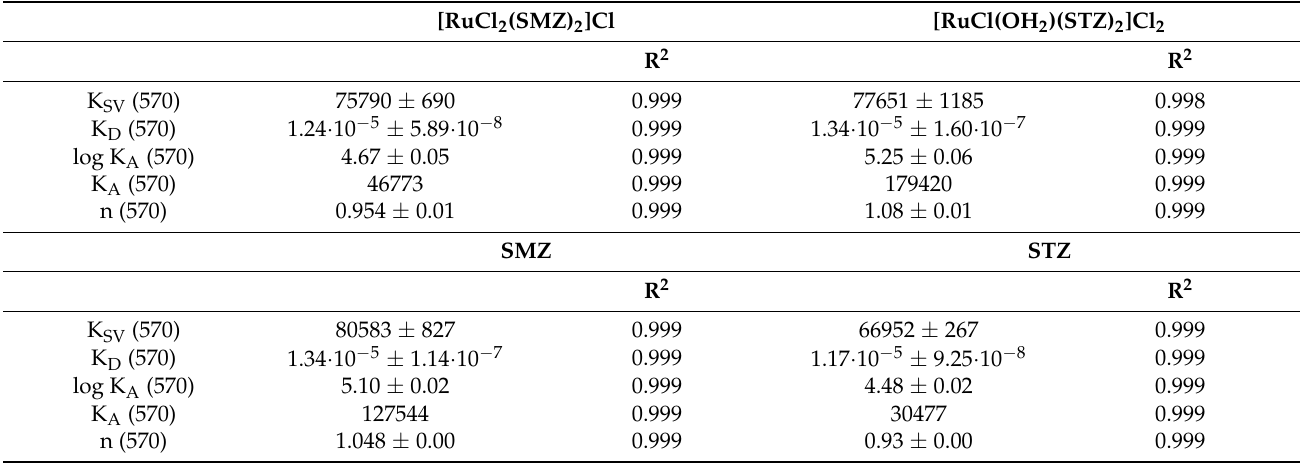
Table 4. Summary of the binding data obtained from the titration of fluorescent probes CT -DNA (K sv —dynamic quenching constant (the Stern–Volmer constant), K D —dissociation constant, K A —association constant, n—number of the binding